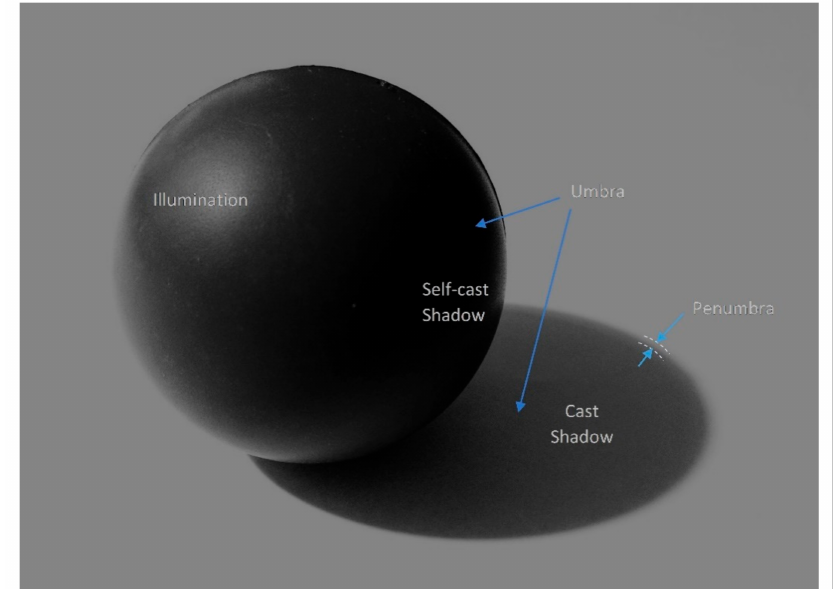
Figure 1. Shadow definitions from Cameron and Kumar